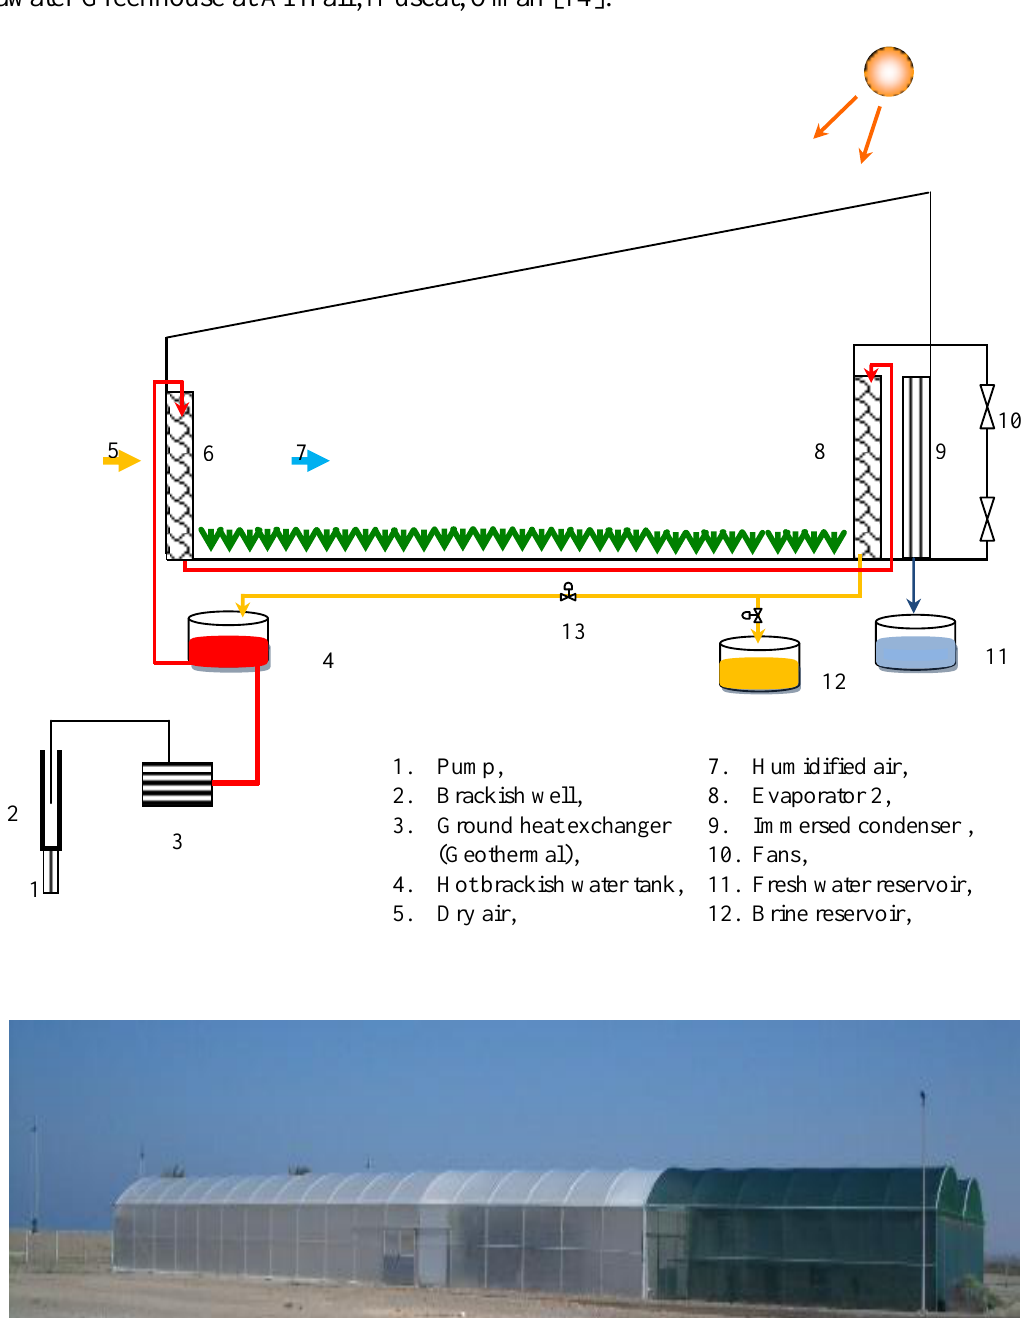
Figure 3. Top (a): Process schematic for Brackish Water Greenhouse coupled to geothermal system [2]. Greenhouse cover is normally plastic sheeting and the feed water to the pump is either brackish groundwater or sea water from a beach well; Bottom (b): The Seawater Greenhouse at Al-Hail, Muscat, Oman